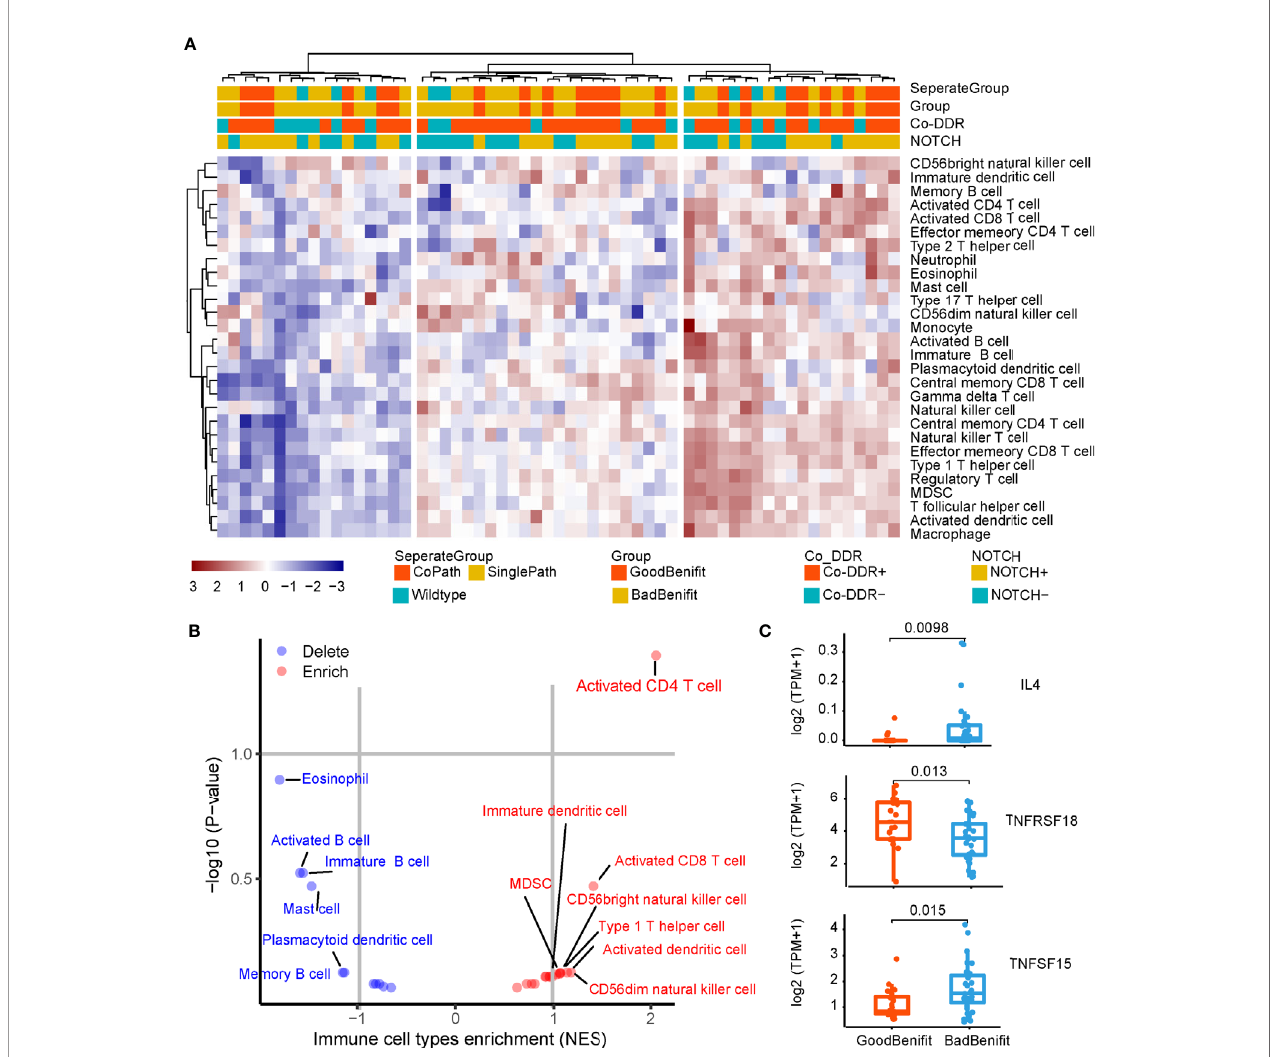
FIGURE 5 | Immunobiology features of NOTCH/co-DDR co-occurrence. (A) Heatmap of immune in fi ltration in each patient. (B) Volcano plots for the enrichment (red) and depletion (blue) of immune cell types for GoodBene fi t and BadBene fi t. The expression levels of genes were fi rst z-score normalized across all patients. Then we calculated the mean z-scores for each group and ranked in descending order. Based on the pre-ranked GSEA method, for each immune cell signature, we de fi ned the q-value <10% and NES >0 as the enrichment, while the q-value <10% and NES <0 as the depletion. Immune cells with absolute NES greater than 1 were shown. (C) Normalized express of immune-related genes between Goodbene fi t versus Badbene fi